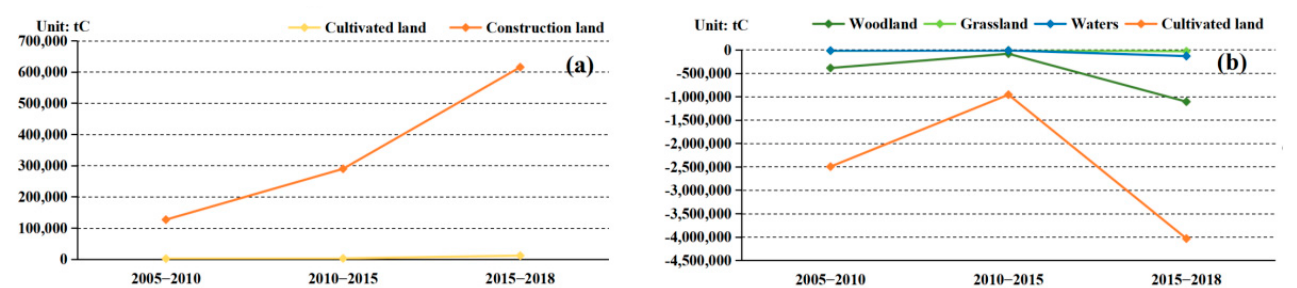
Figure 4. Trends of ( a ) positive and ( b ) negative carbon flow from 2005 to 2018 .